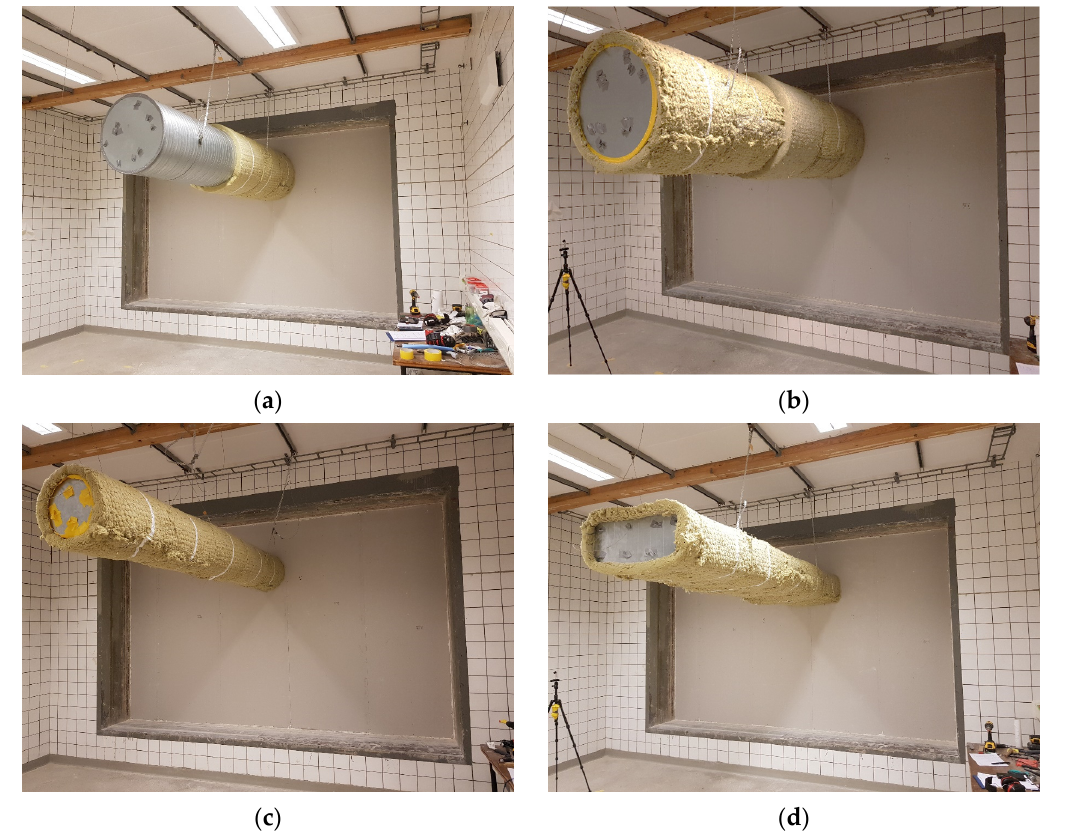
Figure 5. Pictures from the measurements in [2] in one of the rooms: ( a ) Circular 630 mm duct, treatment according to case 3; ( b ) Circular 630 mm duct, treatment according to case 5; ( c ) Circular 315 mm duct, treatment according to case 4; ( d ) Rectangular duct, 700 × 250 mm, treatment according to case 4.